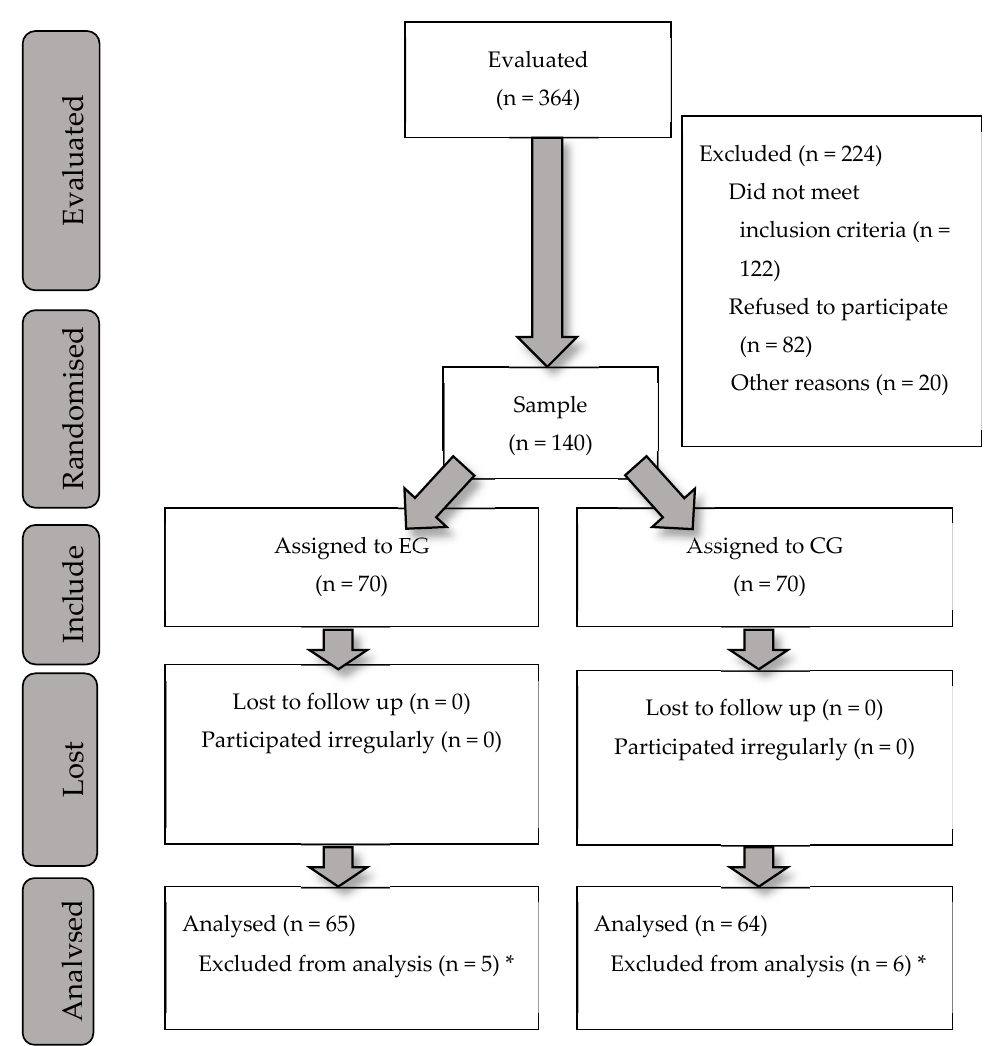
Figure 1. Flow diagram. * The delivery did not take place at the Granada Hospital Complex.